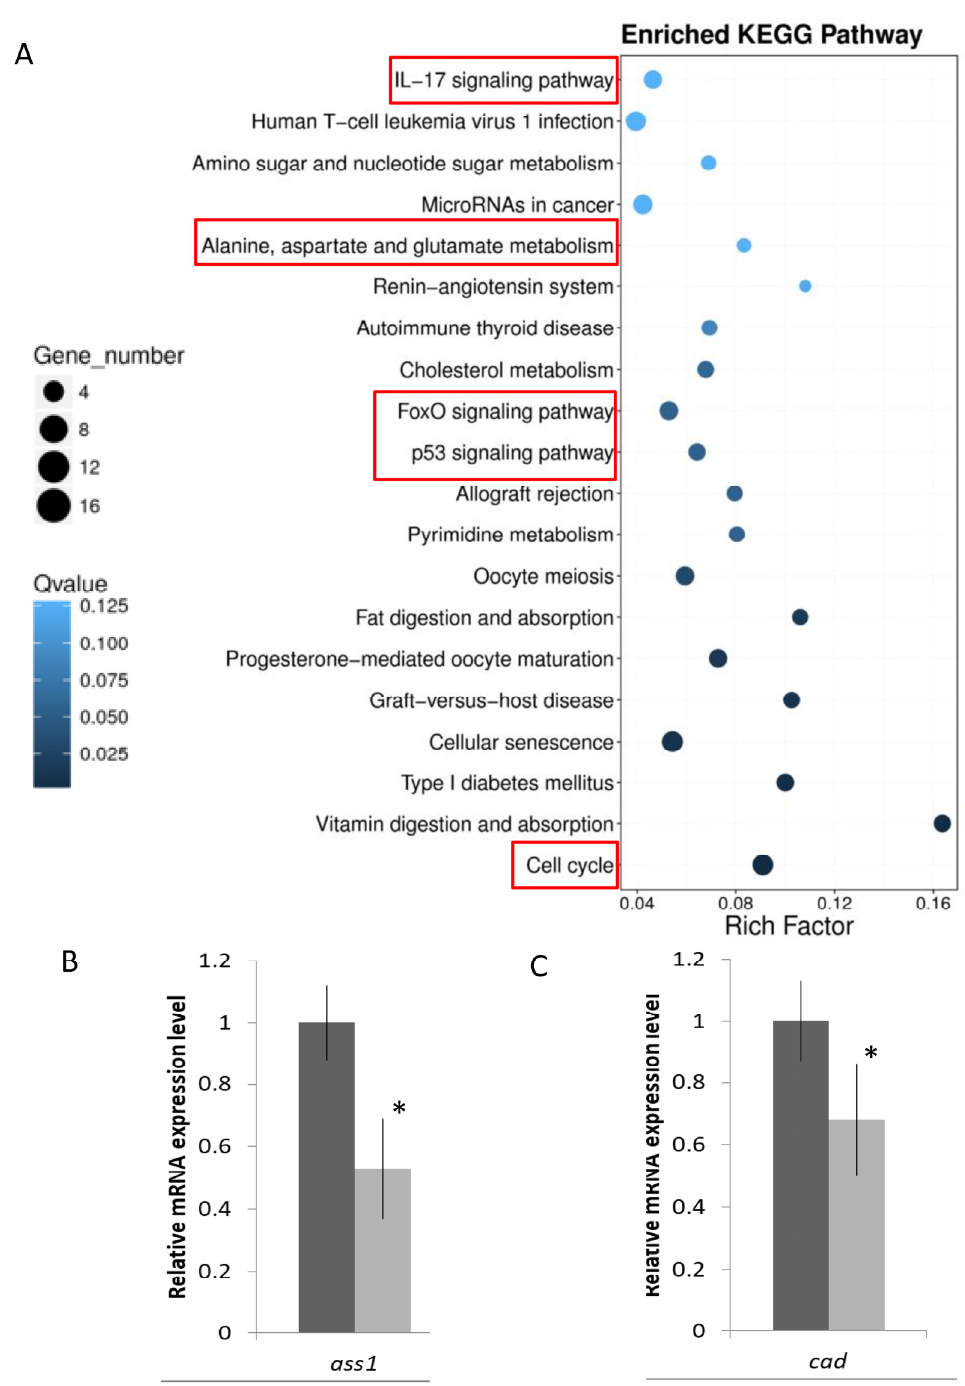
Figure 3. Enriched KEGG pathways in SW/SFW group. ( A ) Pathway functional enrichment of DEGs in SW/SFW group. X -axis represents the enrichment factor, while Y -axis indicates the enriched pathways. The color indicated the q-value; the blue color represented the lower value, while the white color indicated the higher value. In addition, the point size indicated the number of DEGs; bigger dots represented more genes. The greater the rich factor, the more significant enrichment. IL17 signaling pathway, alanine, aspartate, and glutamate metabolism, FoxO signaling pathway, p53 signaling pathway, and cell cycle (red boxes) were found to be enriched in the SW/SFW group. ( B , C ) Validations of the mRNA gene expression levels of two selected alanine and glutamate metabolism related genes ( ass and cad ) transcripts by real time qPCR. Results matched with the sequencing data. n = 5; mean ± s.e., * indicated p < 0.05.